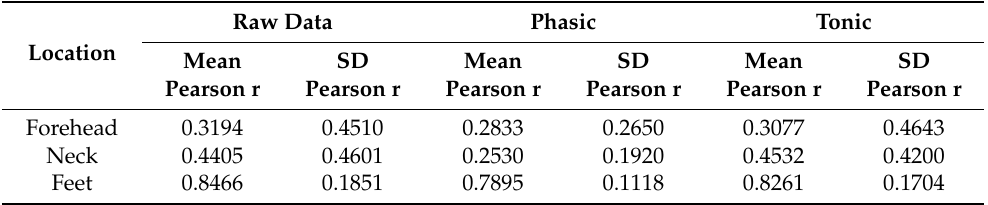
Table 2. Mean and standard deviation of the correlation coefficients between EDA signals from the finger and other body